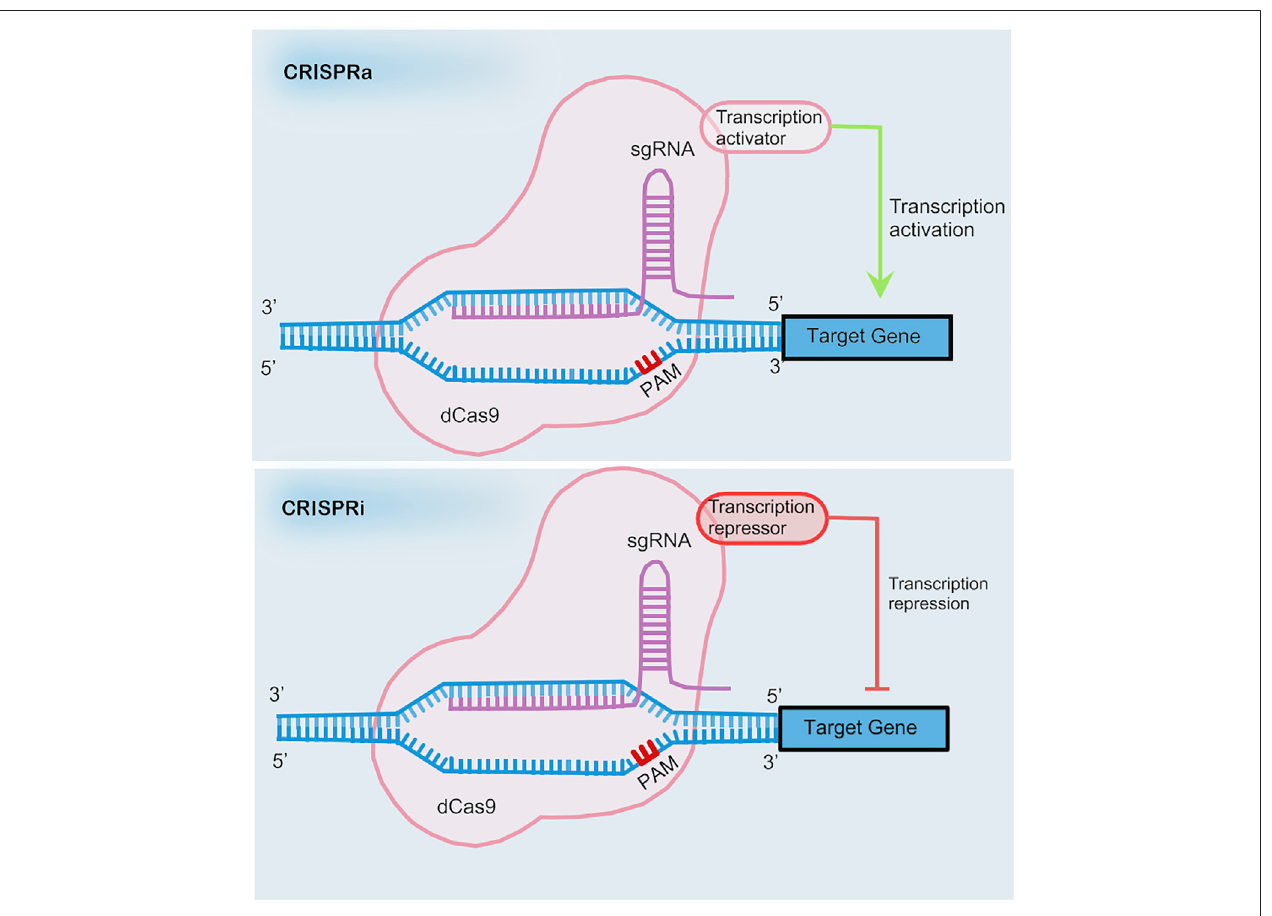
FIGURE 1 | The mechanism of CRISPRa and